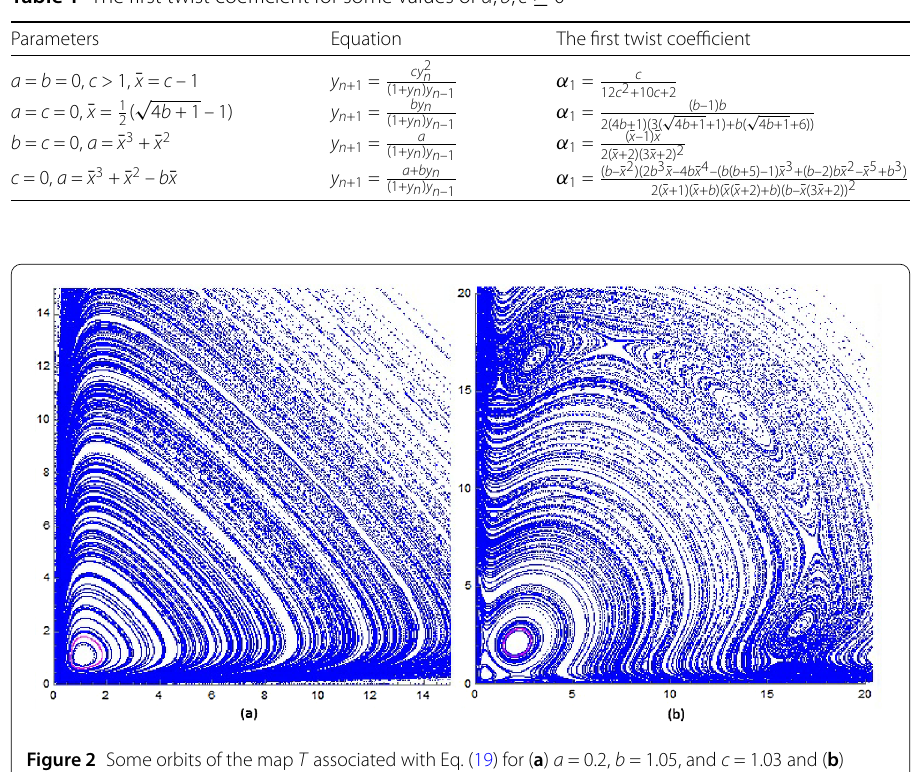
Figure 2 Some orbits of the map T associated with Eq. (19) for ( a ) a = 0.2, b = 1.05, and c = 1.03 and ( b ) a = 0.1, b = 0.05, and c =